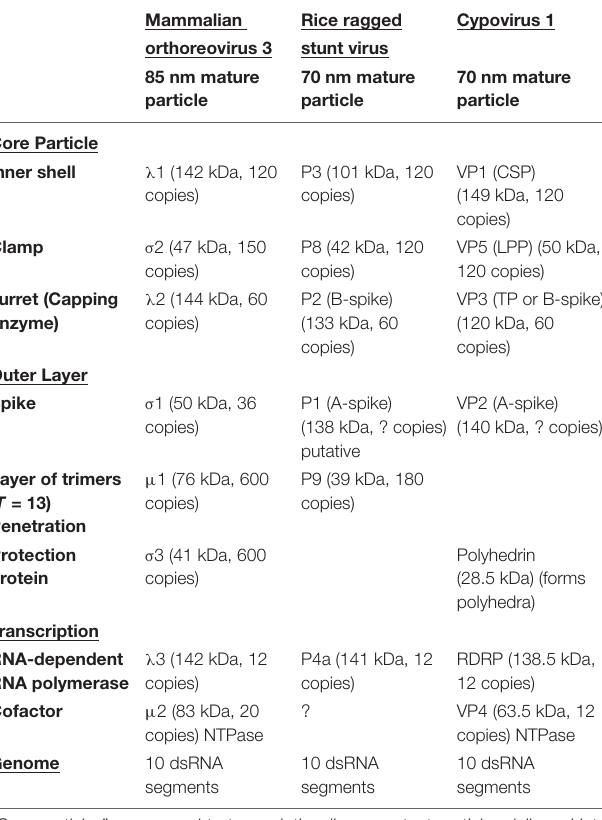
TABLE 2 | Protein and nucleic acid composition of virions of the turreted Spinareovirinae subfamily of reoviruses and representative for the genera Orthoreovirus (Mammalian orthoreovirus 3: Chandran et al., 2001; Mendeza et al., 2008; Sutton et al., 2020), Oryzavirus (Rice ragged stunt virus; Li et al., 1996; Upadhyaya et al., 1996; Miyazaki et al., 2008), and Cypovirus (Cypovirus 1: Yu et al., 2011; Li et al., 2017; Zhao et al., 2018).